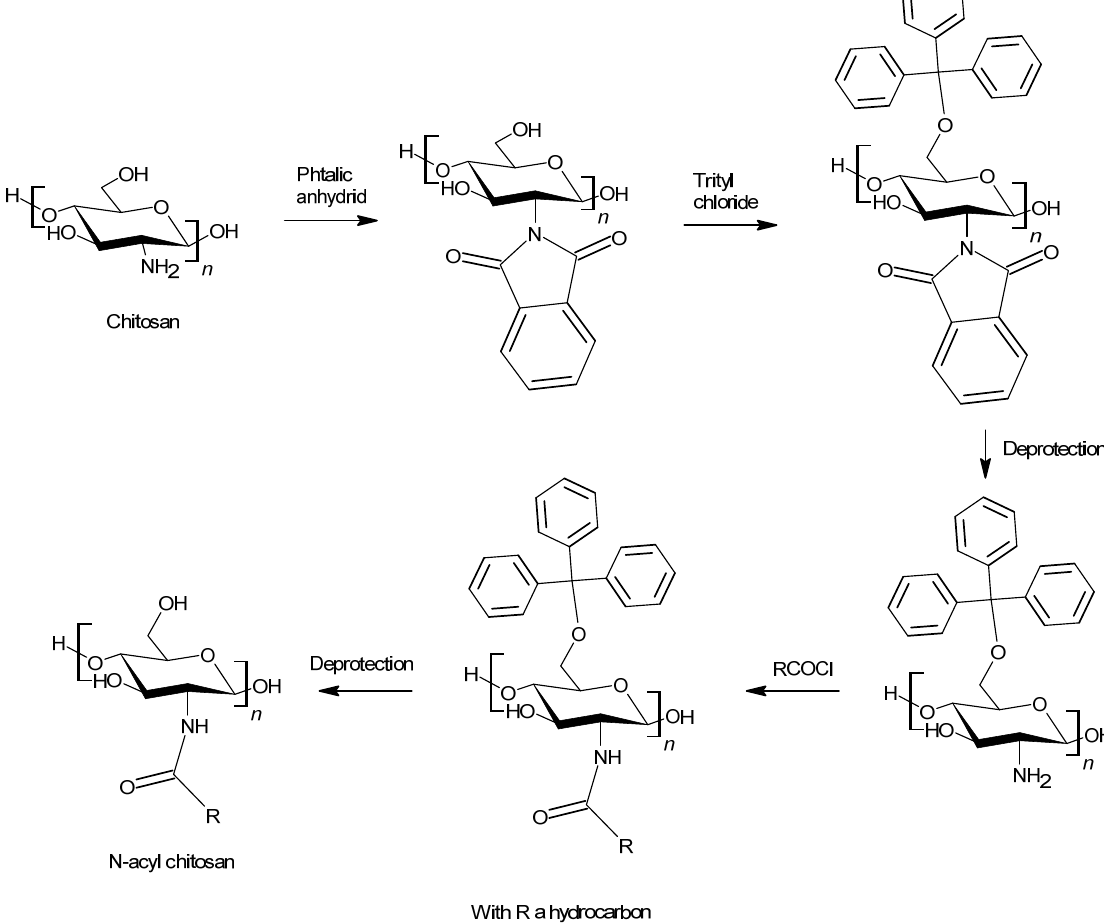
Figure 8. Regioselective example of chitosan acylation .